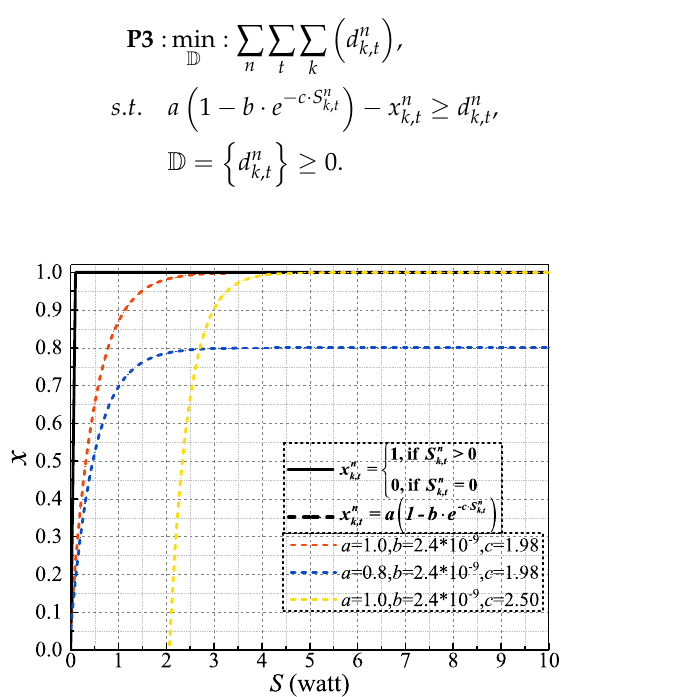
Figure 3. Concave approximation for the Heaviside step